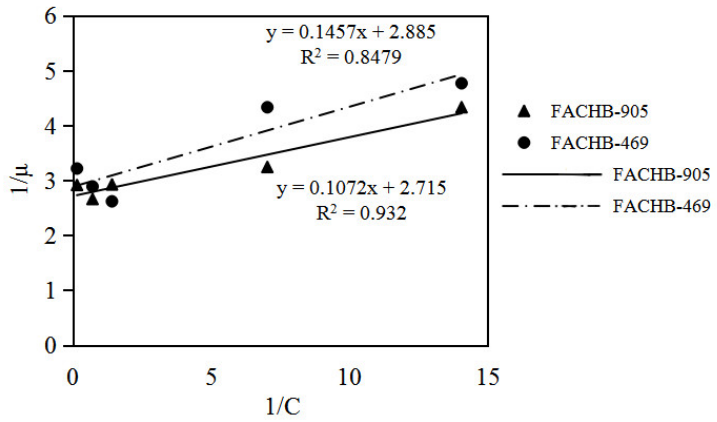
Figure 3. Regression curve between 1/μ and 1/C of FACHB-905 and FACHB-469.